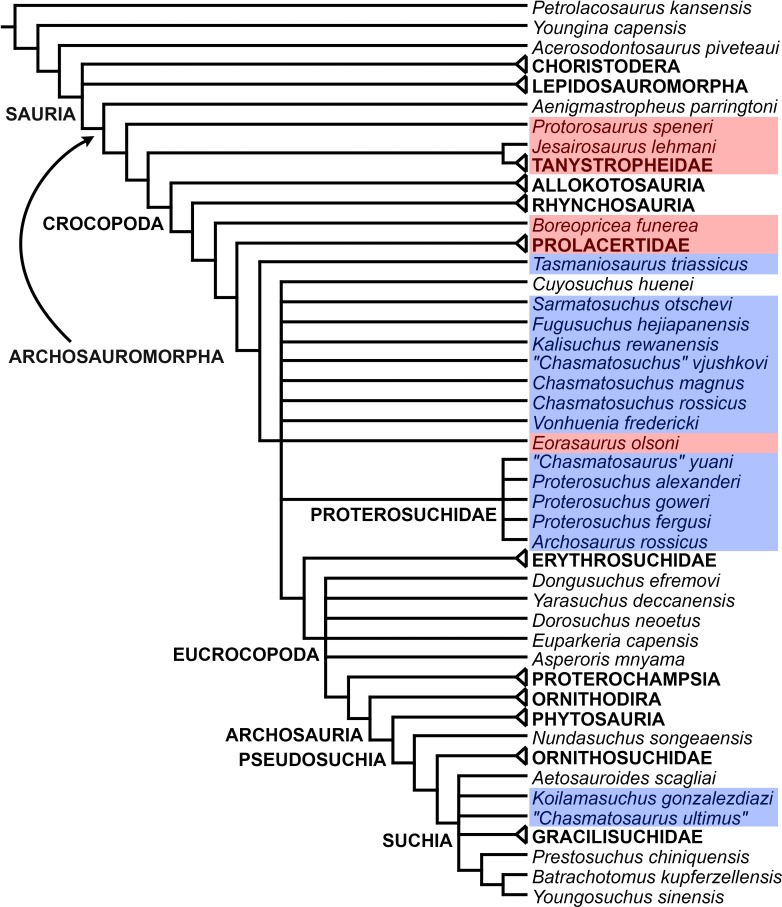
First strict reduced consensus tree recovered from analyses 1 and 2.Putative prolacertiforms and proterosuchids are highlighted in the red and blue boxes, respectively. Some clades have been condensed into suprageneric terminals to simplify the figure and their internal relationships are the same as in previous figures.